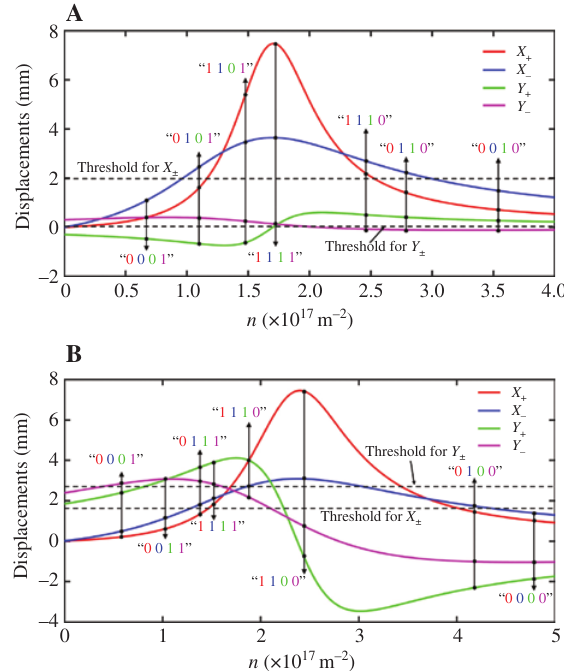
Figure 7: Schematics of barcode encryption based on the asymmetric spin splitting for the cases of ℓ = 0 (fundamental Gaussian beam) and 1 (higher-order LG beam).